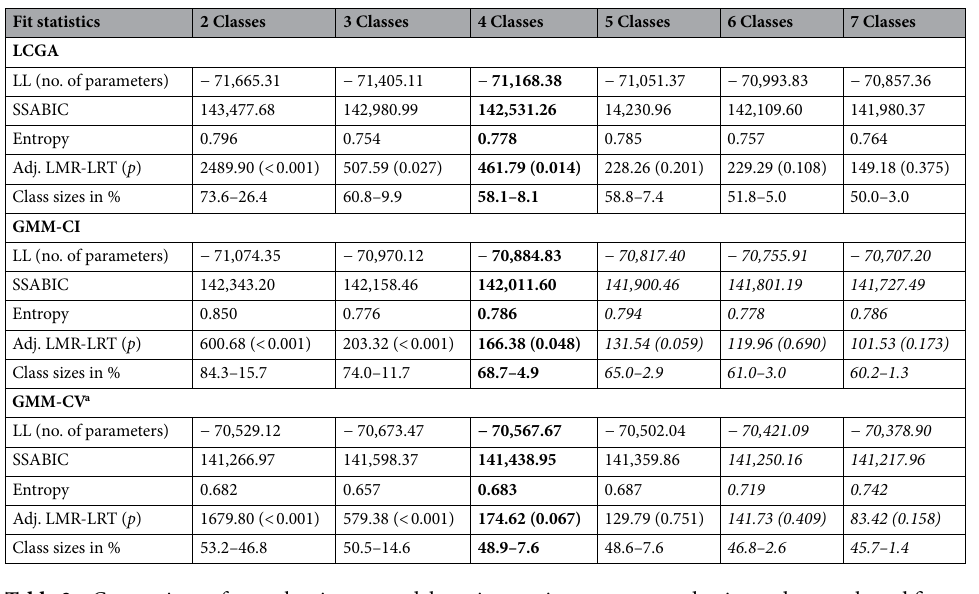
Table 2. Comparison of growth mixture models on insomnia symptoms and pain grade, on selected fit statistics (total N = 2755). The columns in bold text represent the optimal class number. The columns in italics represent models that encountered convergence problems. LCGA latent class growth analysis, GMM-CI growth mixture model with class-invariant variances and covariances, GMM-CV growth mixture model with class-varying variances and covariances. Columns in italics represent inadmissible solutions. Columns in bold represent the optimal solution, LL loglikelihood, SSABIC sample size adjusted Bayesian information criteria, Adj. LMR-LRT adjusted Lo-Mendell-Rubin likelihood ratio test. a For the class-varying models to properly converge, the variance of the intercept factors had to be constrained to be equal across classes, and the slope variances in the largest class had to be constrained to